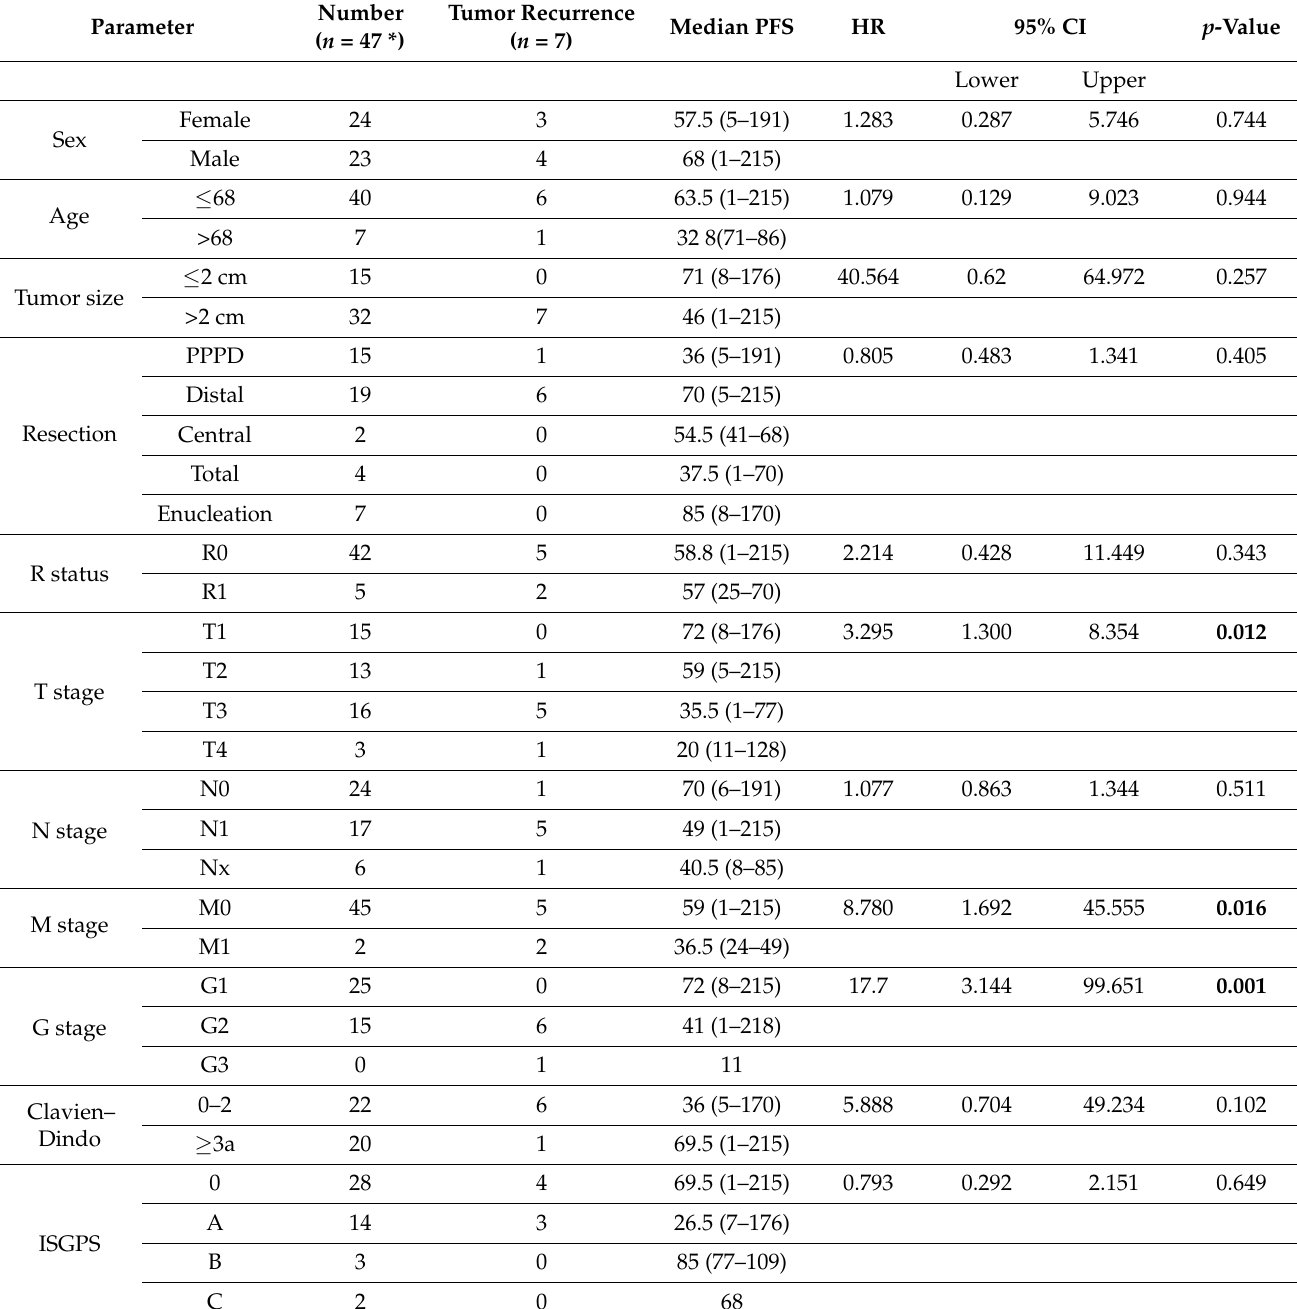
Table 4. Median progression-free survival and univariate Cox regression